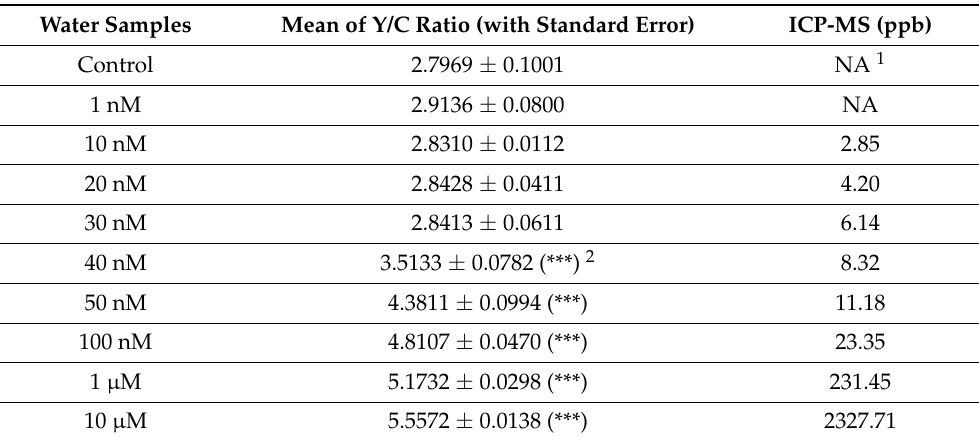
Table 1. Validation of pMet-lead on Pb measurements. The FRET ratios obtained from pMet-lead Pb measurements from various sources of water (Figure 4) were validated by the general standard method